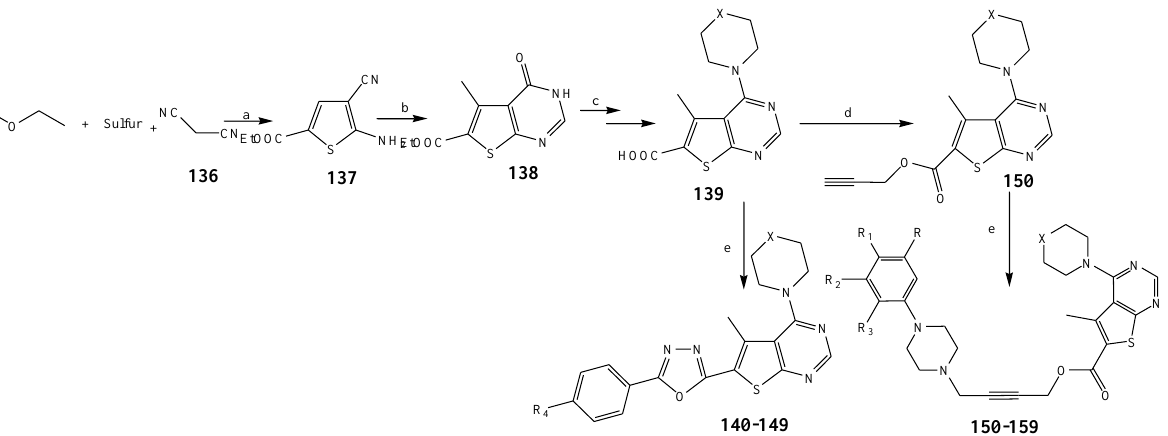
Scheme 11. Synthesis of bis-pyrimidines ( 126 – 134 ).